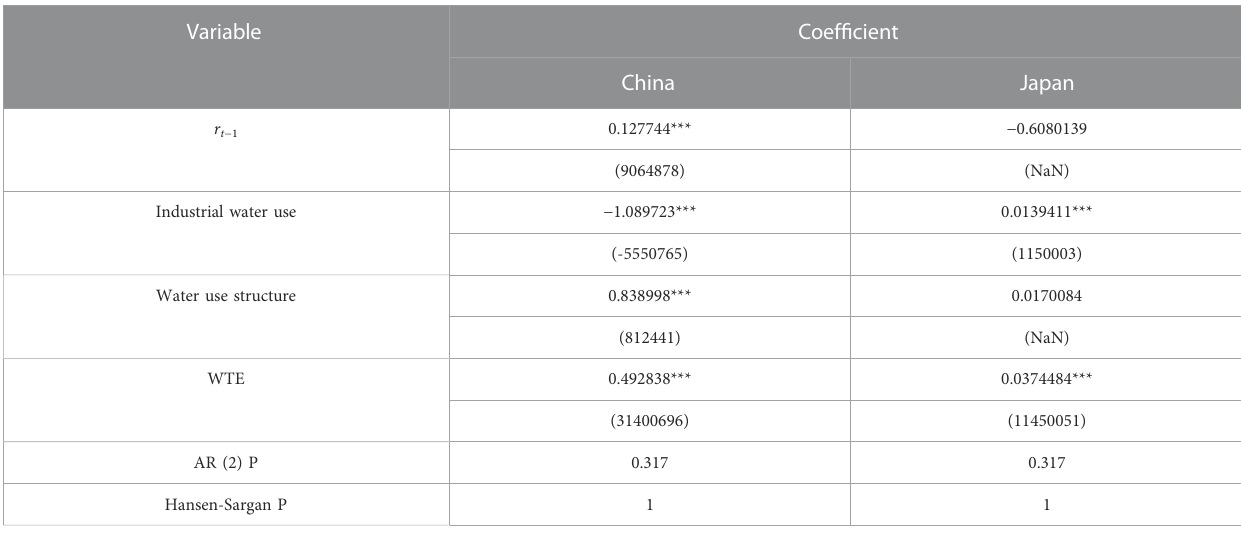
TABLE 6 Role of technology in the stock